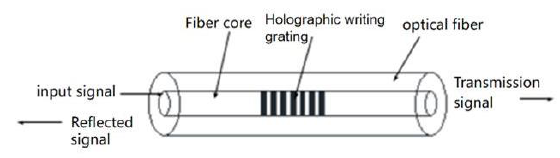
Figure 1. Schematic diagram of